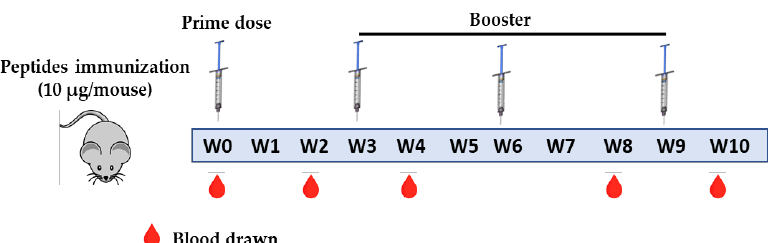
Figure 5. Timeline of the immunization protocol of predicted short peptides in BALB/C mice. W; week.